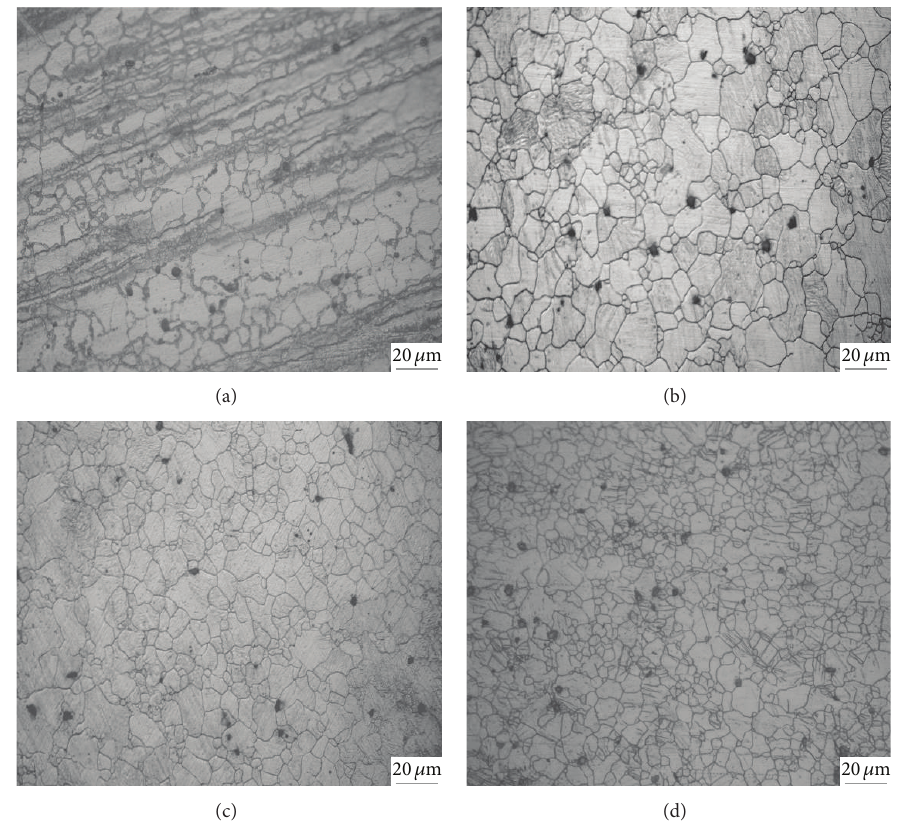
Figure 10: Microstructures of AZ31 magnesium alloy in different parts of ES die (×400) : (a) region “A”, (b) region “B”, (c) region “C”, and (d) region